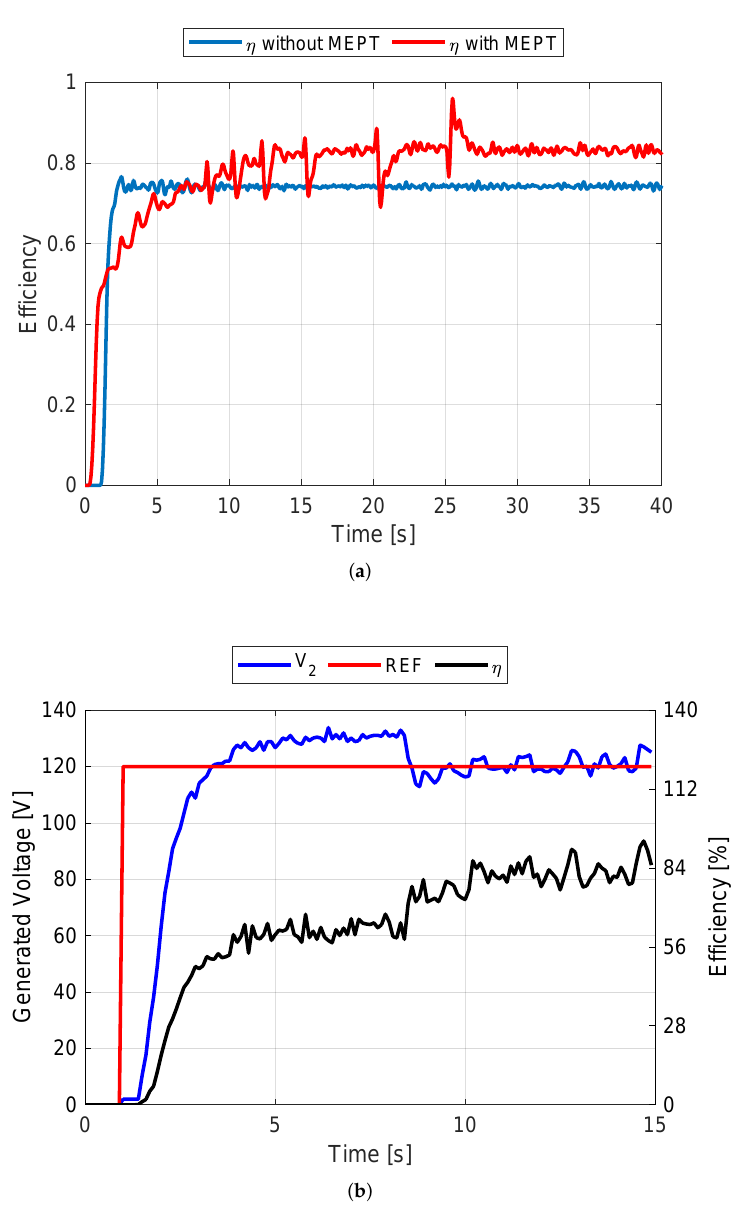
Figure 16. Simulation and experimental results for 120 V reference: ( a ) Simulation result: efficiency increase with MEPT algorithm; ( b ) Experimental result: controller performance and GRC throughput. As the last experimental procedure to validate the MEPT algorithm in parallel with the voltage PID controller, the reference was raised to 140 V. The results for this test are shown in Figures 17 and